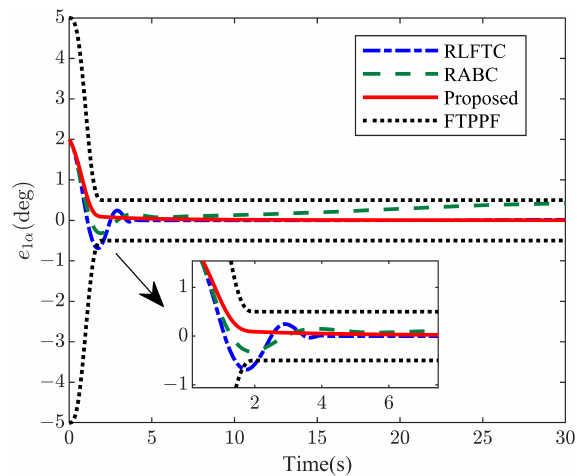
Figure 3. Time histories of the attitude tracking error e 1 α